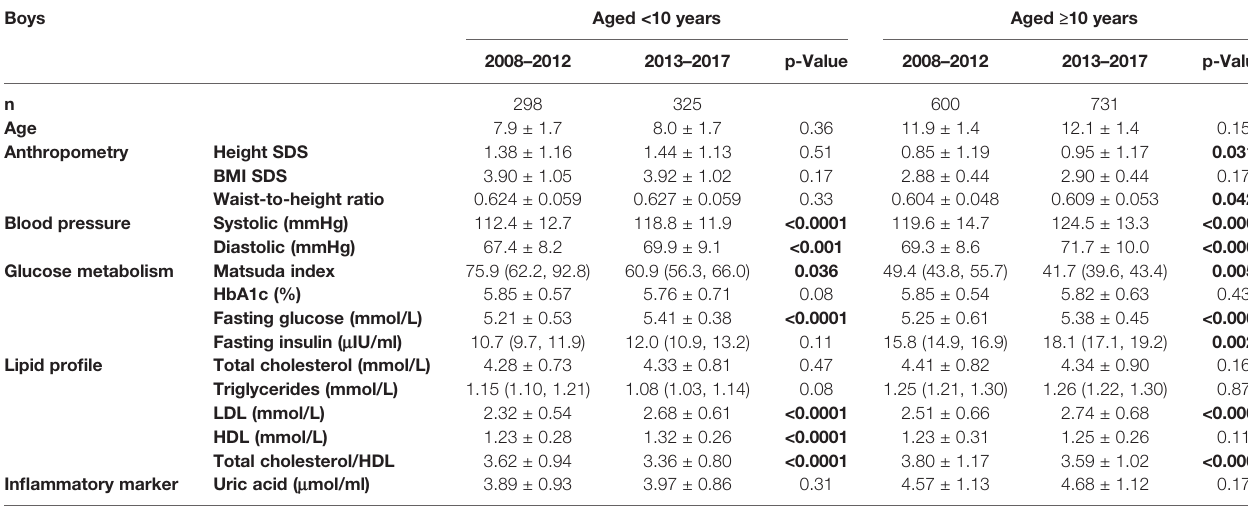
TABLE 5 | Cardiometabolic parameters among Chinese boys with obesity assessed between 2008 and 2017 in Hangzhou (Zhejiang Province, China). Boys